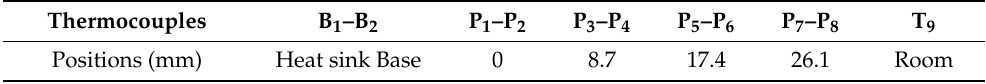
Table 3. Locations of eleven thermocouples placed on the heat